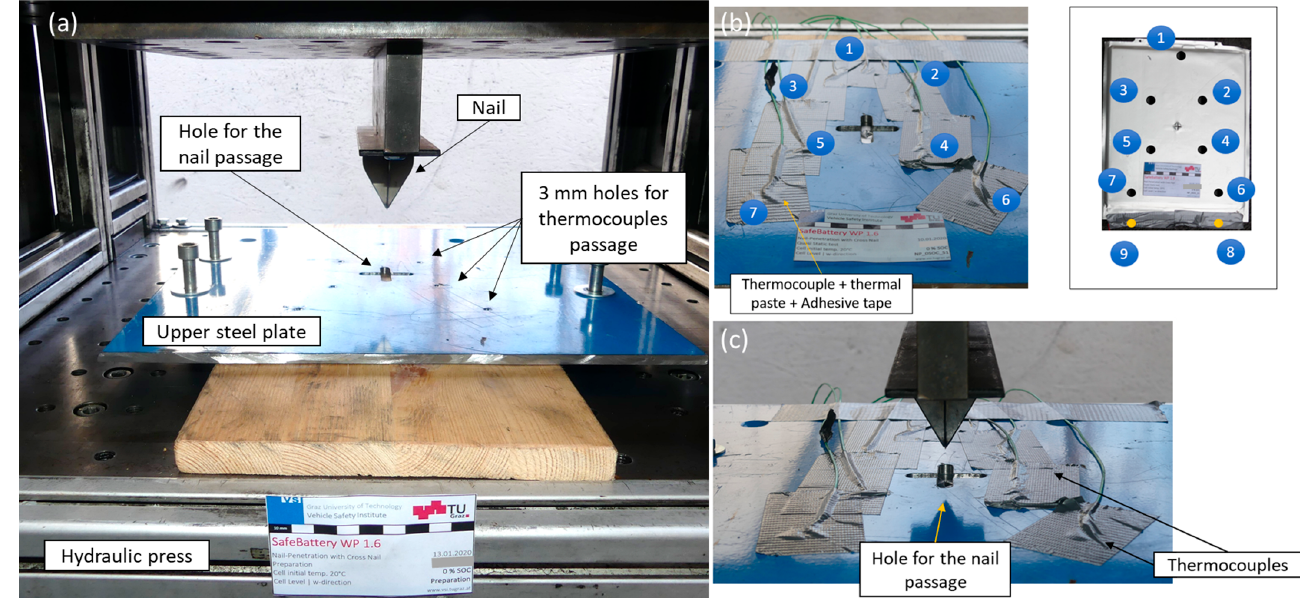
Figure 5. Overview of the test setup. ( a ) A wood plate was placed below the Li-ion cell to protect the quasi-static hydraulic press and a steel plate was placed on top of the cell to keep the cell in position during the thermal runaway event; ( b ) thermocouples numbering and positions; the sensors were in contact with the cell through holes (3 mm diameter) on the steel plate, additional thermal paste was applied for each thermocouple then finally fixed with adhesive tape; and ( c ) thermocouples were positioned to sense the temperature gradient on the cell surface, extending from the area surrounding the nail to the edges.